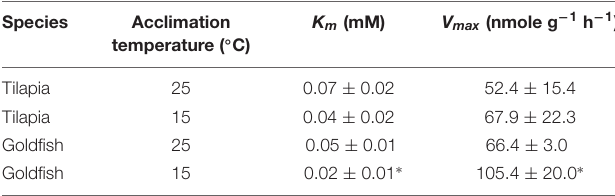
Values shown are mean ± S.D. Calcium influx rates were measured at 25 ◦ C. ∗ Significant difference between 15 and 25 ◦ C acclimated groups in the same species (Student’s t-test, p ≤ 0.05, N =